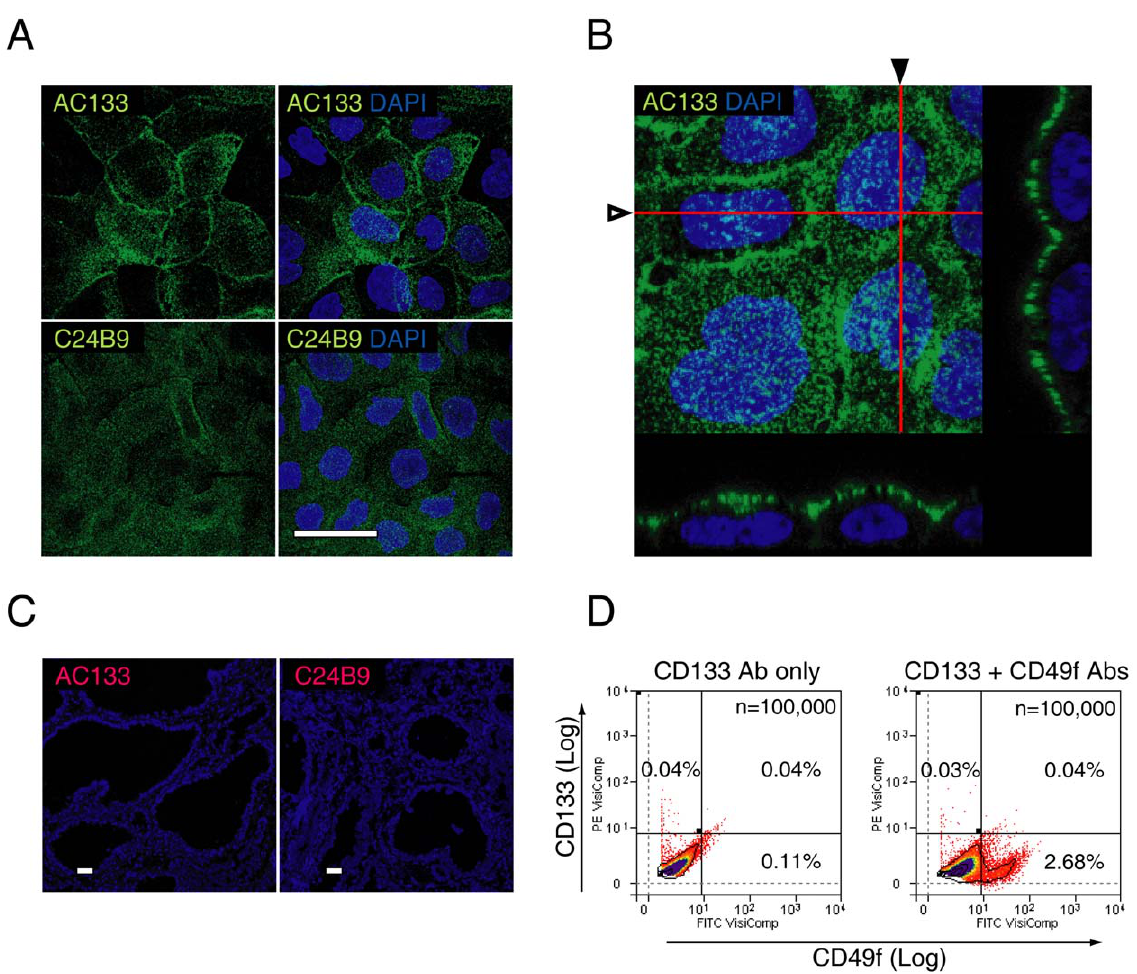
Figure 4. CD133 expression in frozen prostate tissue sections. Validation of CD133 (clones AC133 and C24B9) antibody specificity and expression in the human prostate. [ A ] Punctate expression was shown on the cell surface of Caco-2 cells for clones AC133 and C24B9, as described previously [21]. [ B ] Orthogonal sectioning following three-dimensional reconstruction of 150 slices (red lines marked by hollow and solid arrowheads indicate the x-z planes shown below, or to the right of the confocal image, respectively) indicate CD133 expression only along the apical border of the plasma cell membrane [21]. [ C ] Immunohistochemical expression of AC133 and C24B9 in prostate tissue. Each frozen tissue section measured 10 6 10 mm in cross-sectional area. Following examination of 20 slides each from 5 patients, we found no cell with definitive membrane